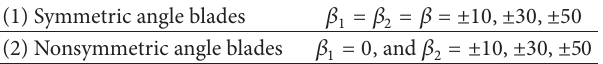
Table 4: Definition of symmetric and nonsymmetric angle